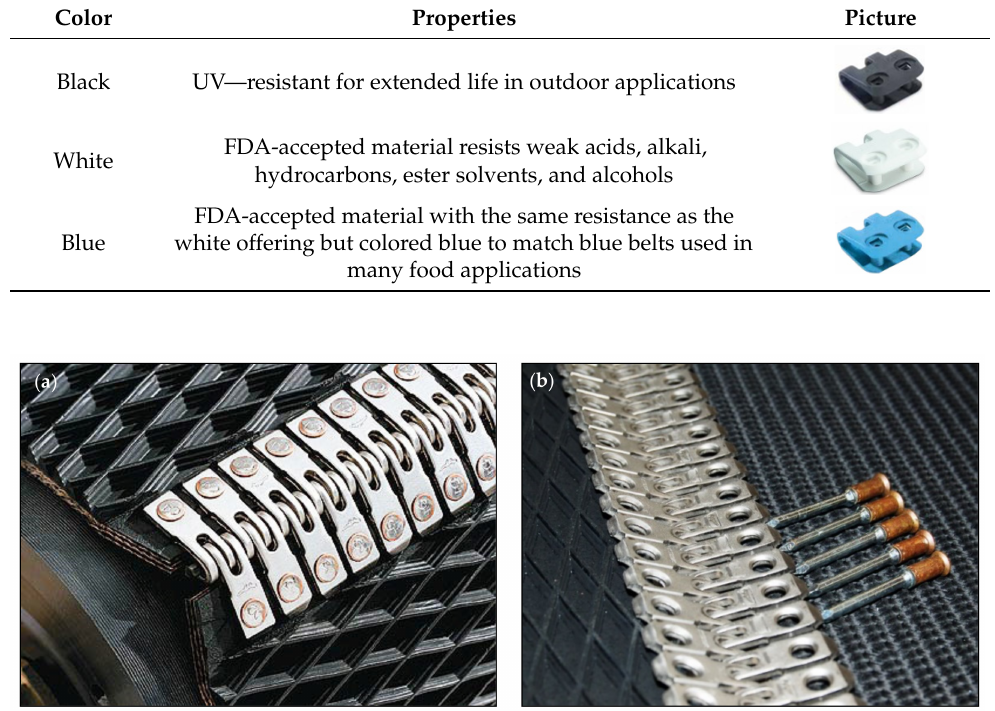
Figure 12. Rivet fastening: ( a ) general view; ( b ) individual items